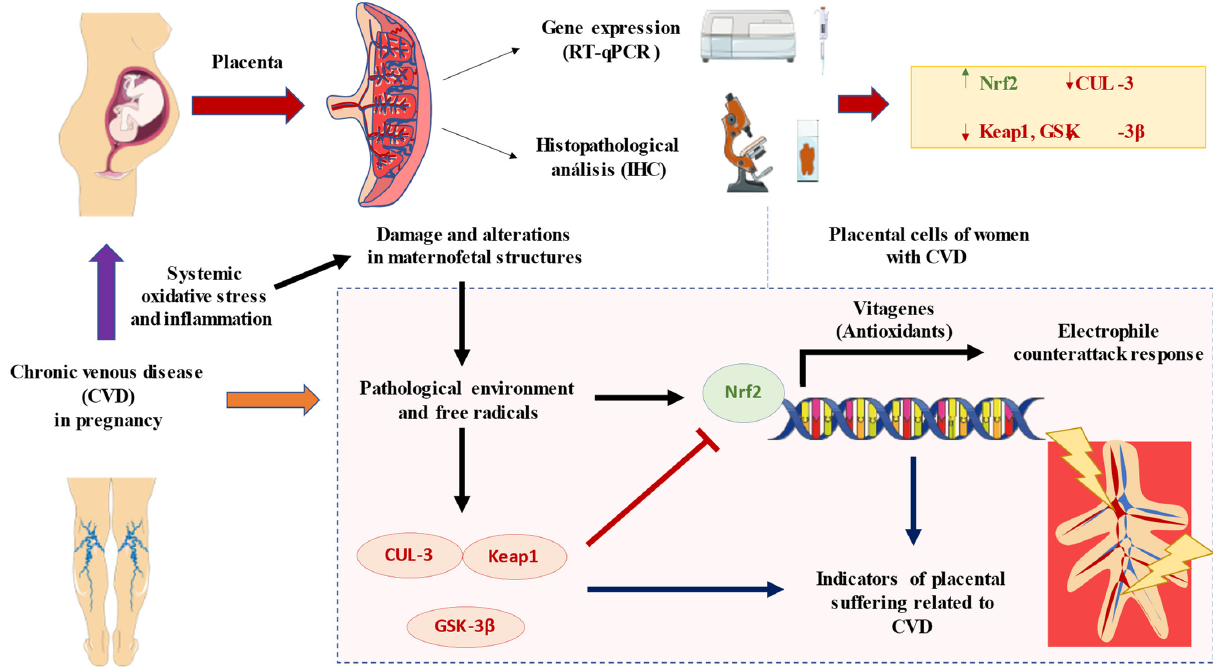
Figure 5. A global summary of the results obtained in this study. As shown, CVD during pregnancy is associated with systemic oxidative stress and inflammation that may have detrimental consequences for the maternofetal structures. In the present work, we have evidenced an enhanced expression of Nrf2 along with a reduced CUL-3, Keap1 and GSK-3 β . Collectively, these findings suggests that the pathological environment and oxidative stress observable in the placenta of these women may lead to the dysregulation of these products, leading to the expression of several “vitagenes” involved in the electrophile counterattack response and potentially evidencing placental suffering in women with CVD.